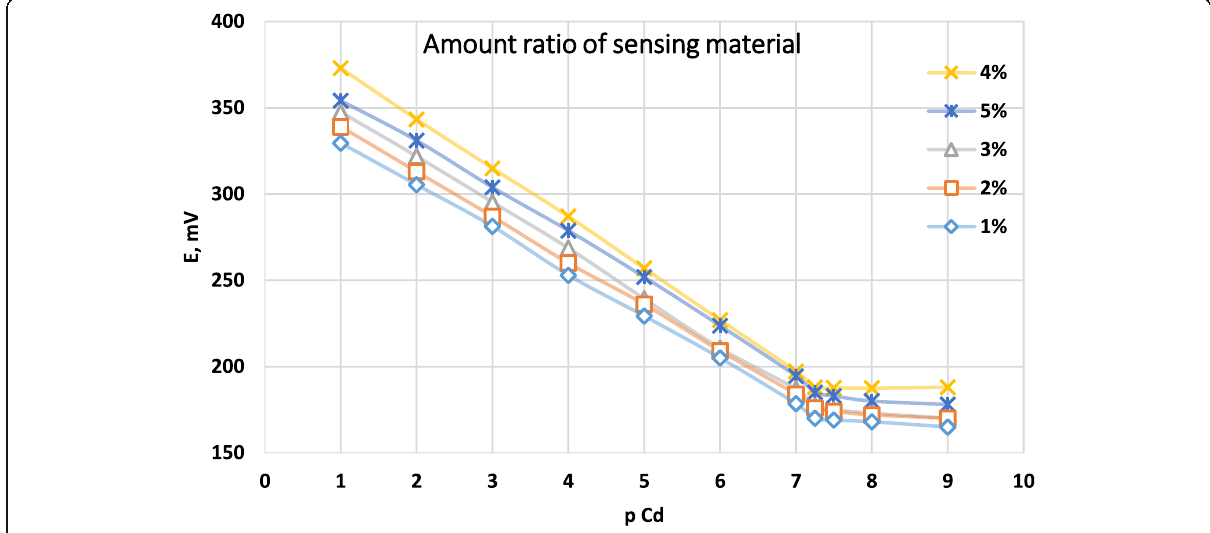
Fig. 1 Impact of the amount ratio of sensing material on efficiency of